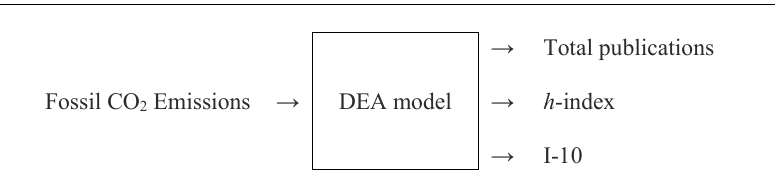
Fig. 1. The structure of the proposed